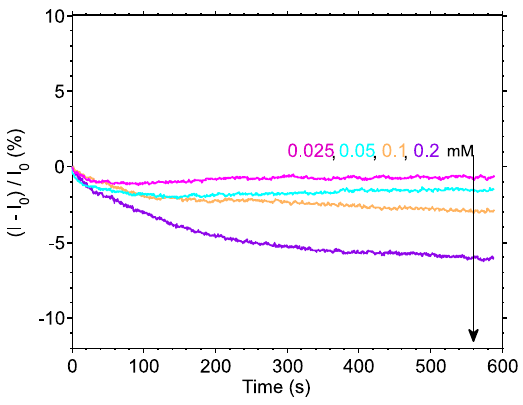
Figure 5. Filtered transient results of Figure 3b. The applied digital filter clearly allows us to increase our system’s resolution even further.